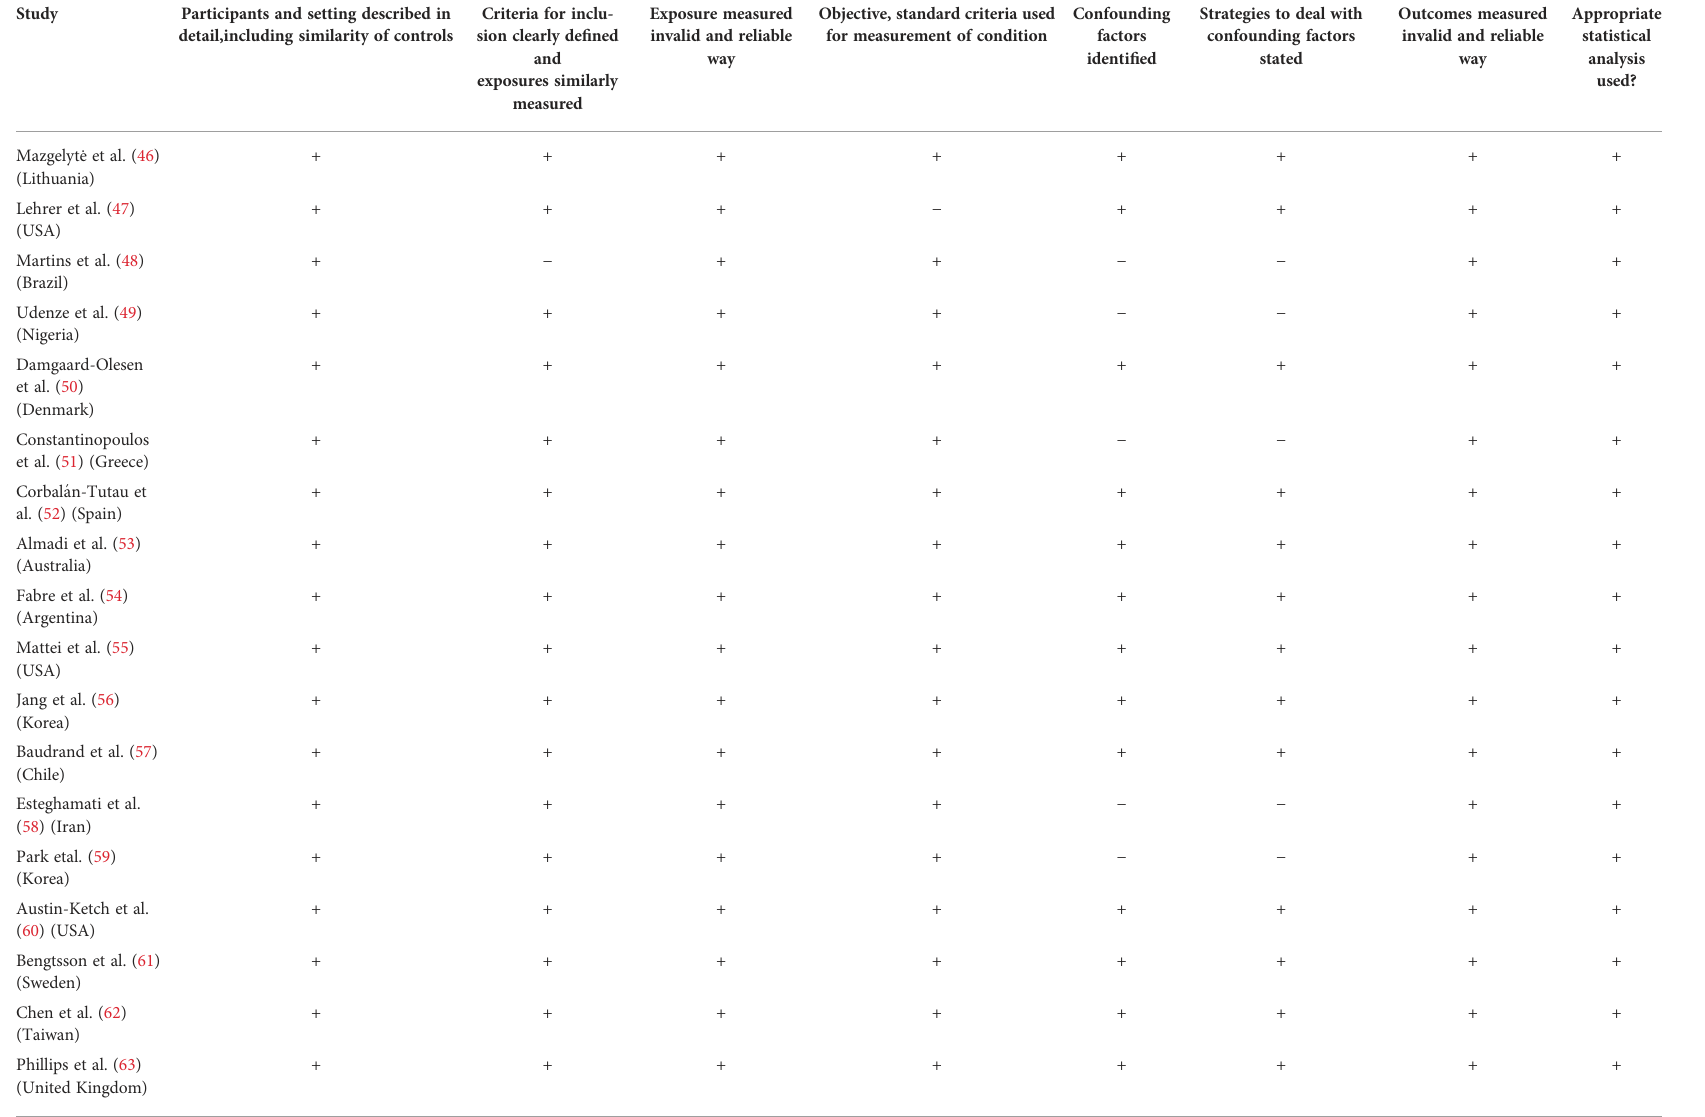
TABLE 2 Joanna Briggs Institute (JBI) scores for cross-sectional